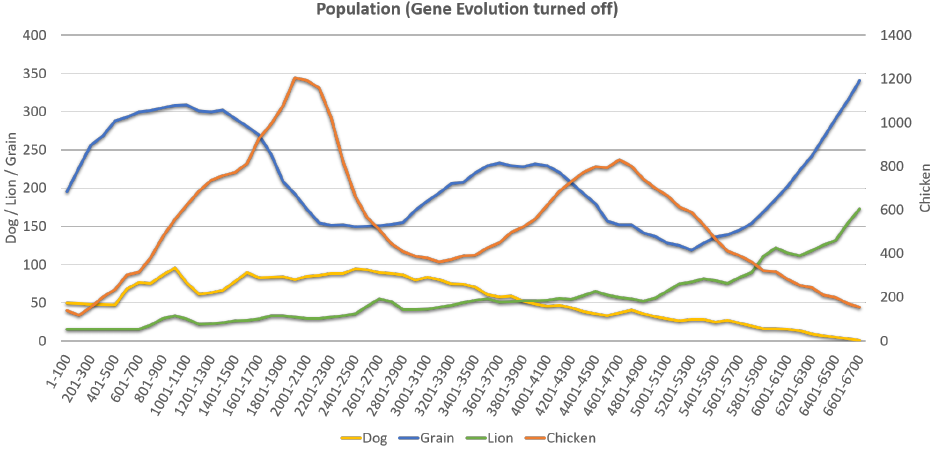
Figure 17. Population fluctuation during the simulation without evolution.